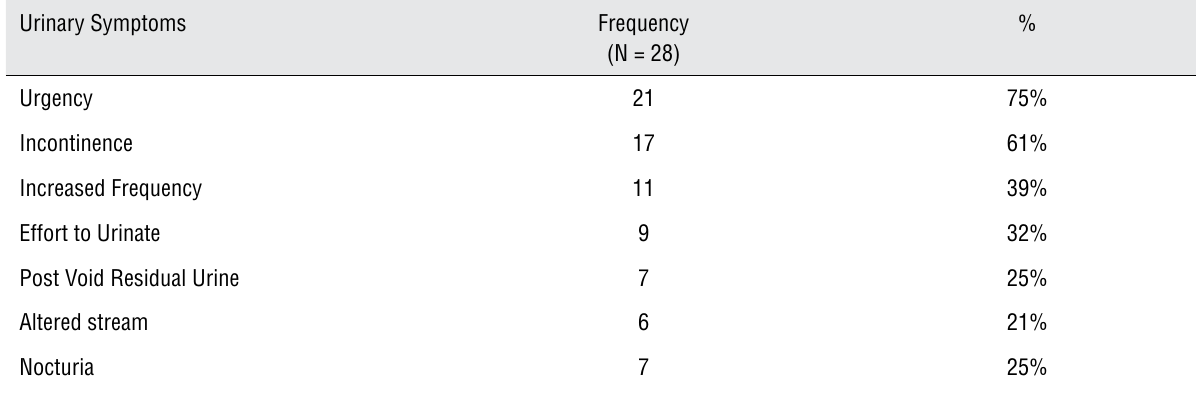
Table 3 - Frequency of urinary symptoms in the 28 patients who participated in the urodynamic study. Urinary